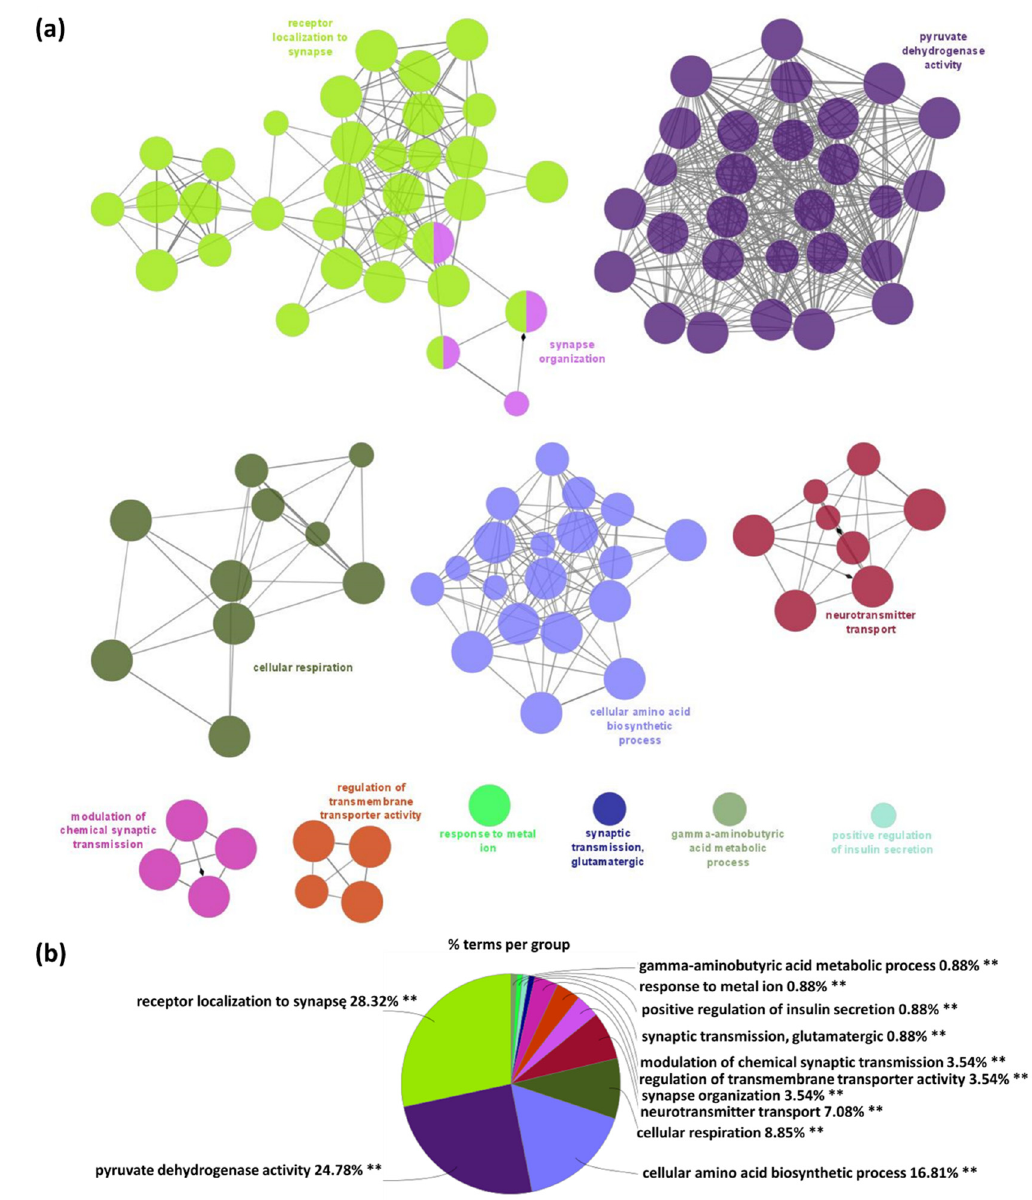
Figure 3. Functional enrichment analysis of proteins specific for female WT mice using the Gene Ontology biological processes database and the Clue Go algorithm. ( a ) Network depicting interactions between enriched functional classes. Each circle represents a biological term consisting of various related proteins/genes. Terms that belong to the same pathway are shown with the same color, and terms associated with two different pathways are marked with two colors. The size of the circles relates to the statistical significance of the term enrichment. The connectivity (edges) between the terms in the network is derived from kappa score, (indicates the similarity of associated genes shared by different terms). Thicker edges indicate stronger similarity. Diamonds represent directed edges which link parent terms to child terms. Only the name of the most significant term in each group is shown to reduce overlay. ( b ) A diagram showing the percentage of terms per group of enriched protein classes.